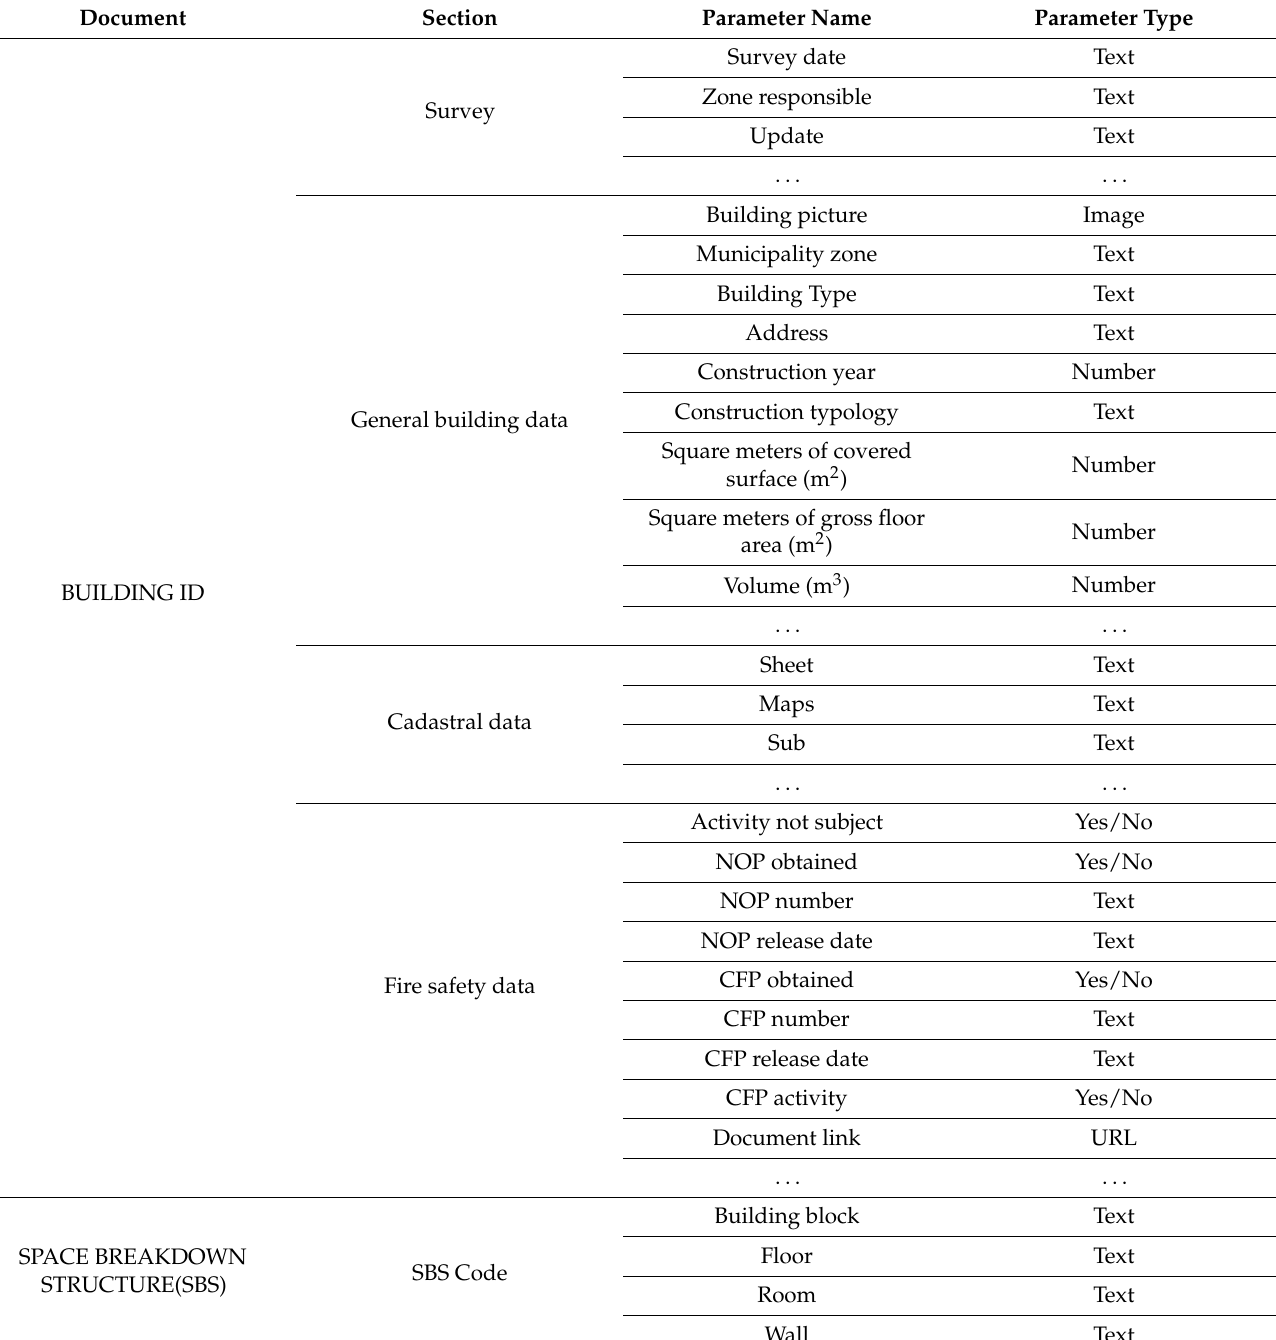
Table 1. Data and parameter definitions. Blue: Data coming from the related